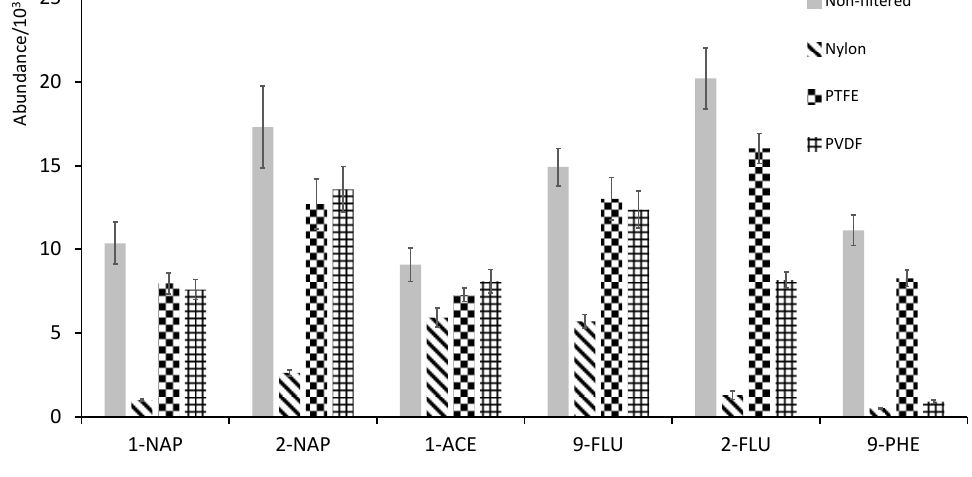
Figure 2. Test of filter materials.